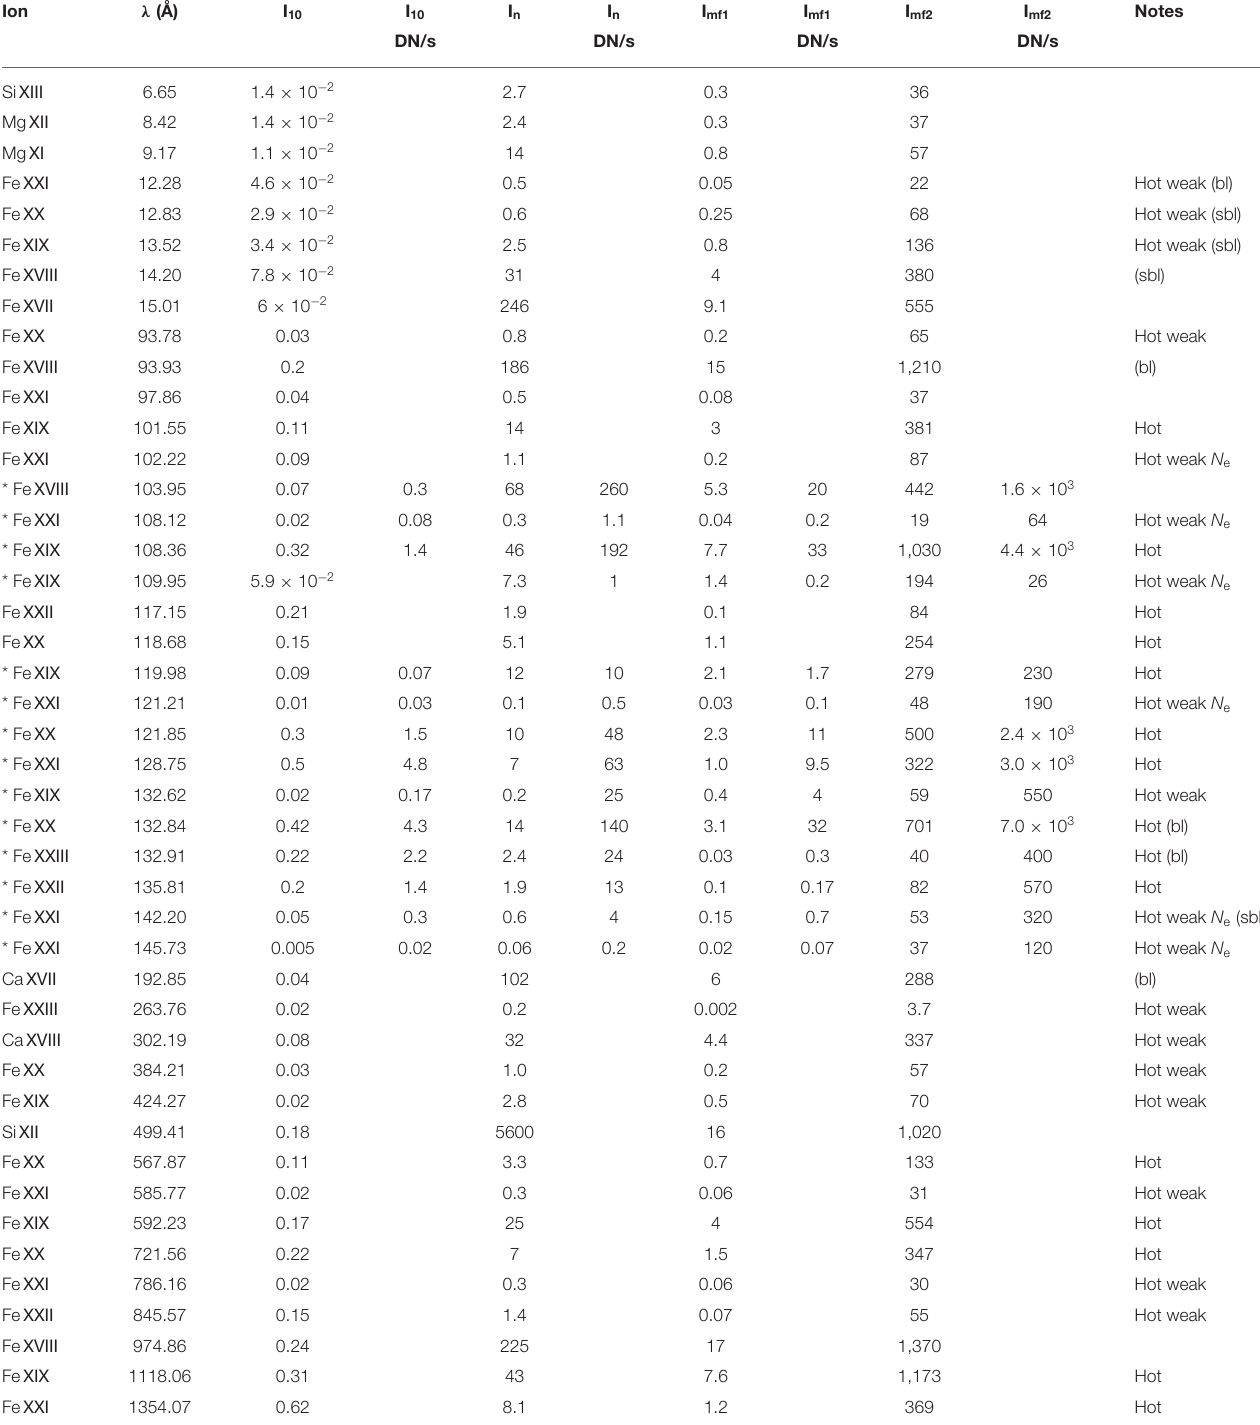
TABLE 1 | List of the strongest lines in the XUV for a 5–10 MK